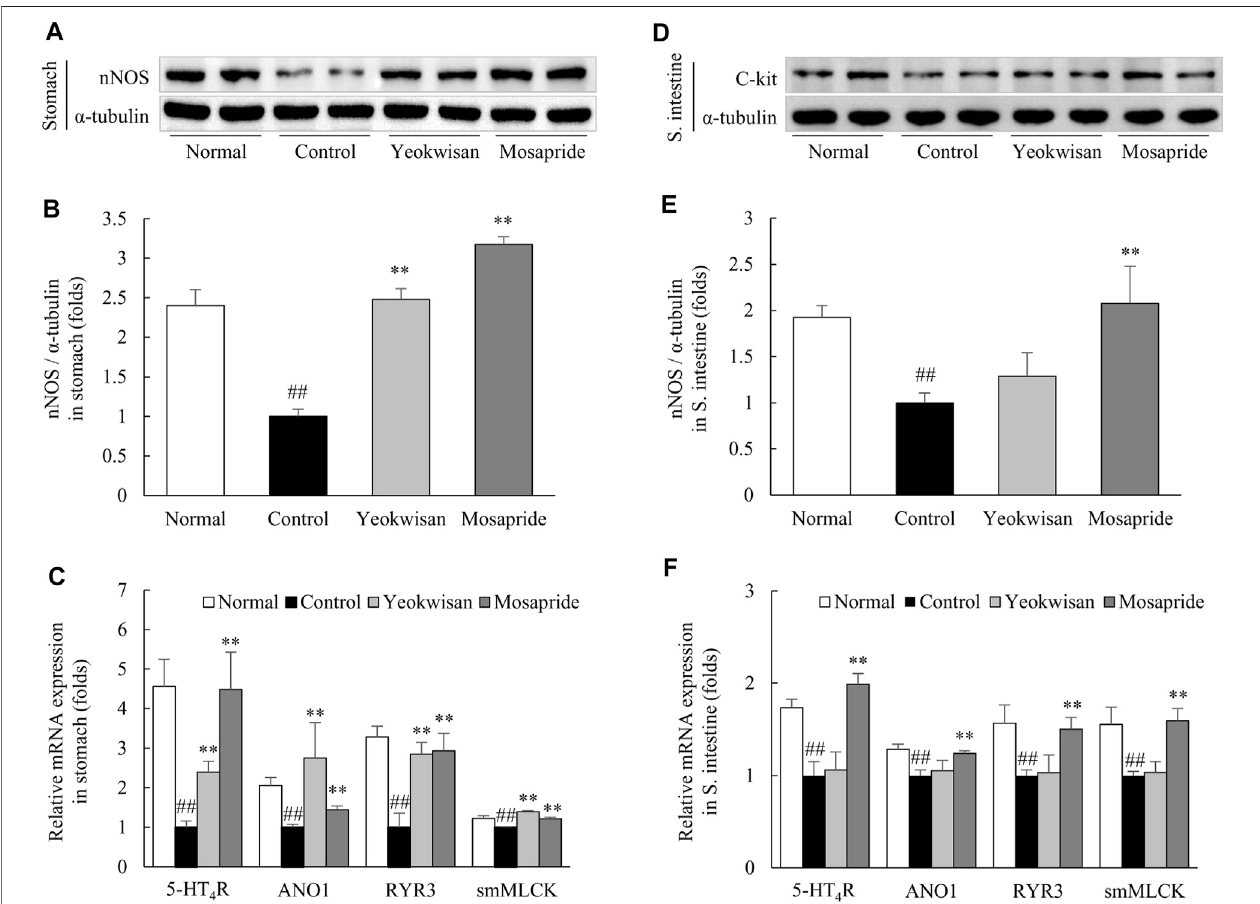
FIGURE 5 | Effects of Yeokwisan on the expression of the nNOS protein and contraction-related genes in stomach and small intestine tissues. Western blotting analysis of nNOS and semiquanti fi cation of the data were performed in stomach (A,B) and small intestine (D,E) tissues. mRNA expression analyses for four GI motility- associatedgeneswereconducted onstomach (C) andsmallintestine (F) tissues.The Yeokwisan groupwastreatedwithadoseof400 mg/kgintheseresults.Thedata arepresentedasthemean ± SEM.## p < 0.01comparedwiththenormalgroup;** p < 0.01comparedwiththecontrolgroup.nNOS,neuronalnitricoxidesynthase; 5-HT 4 R, 5-HT 4 receptor; ANO1, anoctamin-1; RYR3, ryanodine receptor 3; smMLCK, smooth muscle myosin light chain kinase.